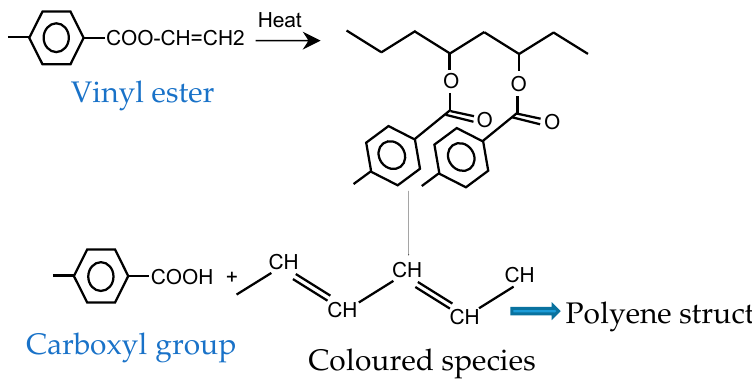
Figure 7. Formation of colored species in PET-derived structures.